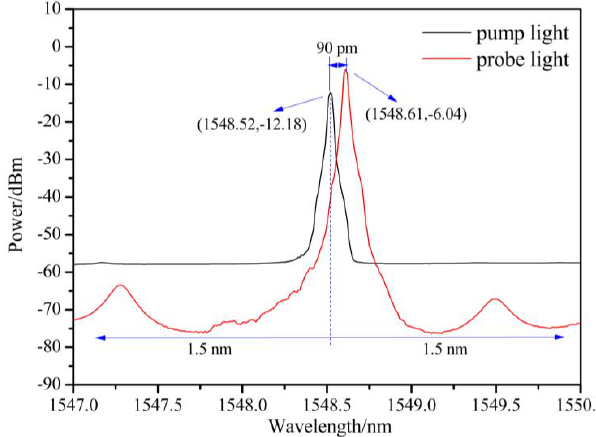
Figure 5. The frequency drift between the pump light and the probe light.